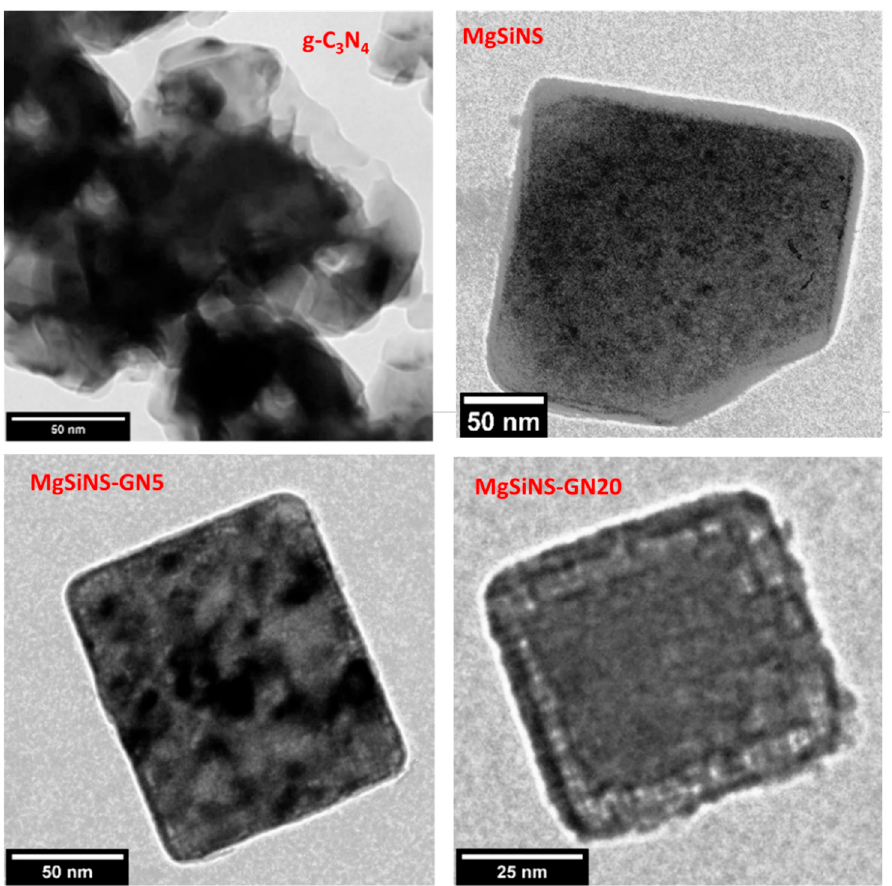
Figure 2. TEM images of MgSiNS, g-C 3 N 4, MgSiNS-GN5, and MgSiNS-GN20 samples.